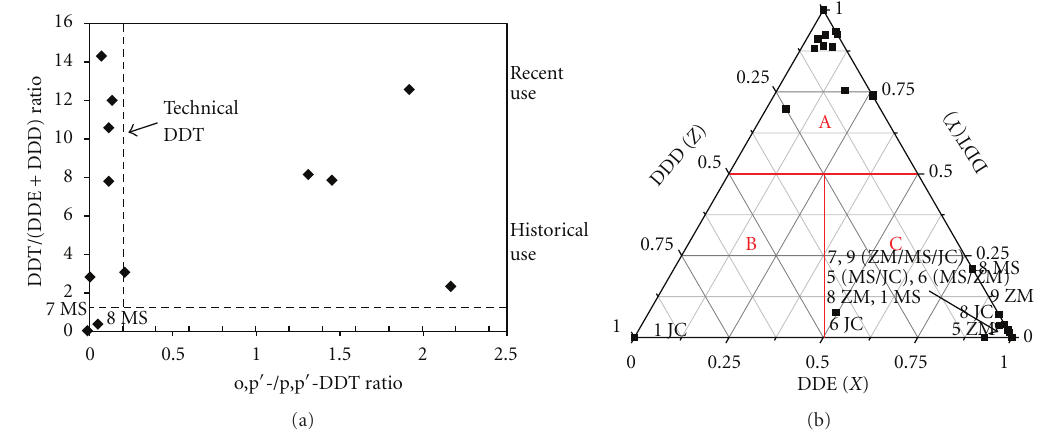
Figure 7: The identification of the DDT sources in the water from Lake Chaohu.